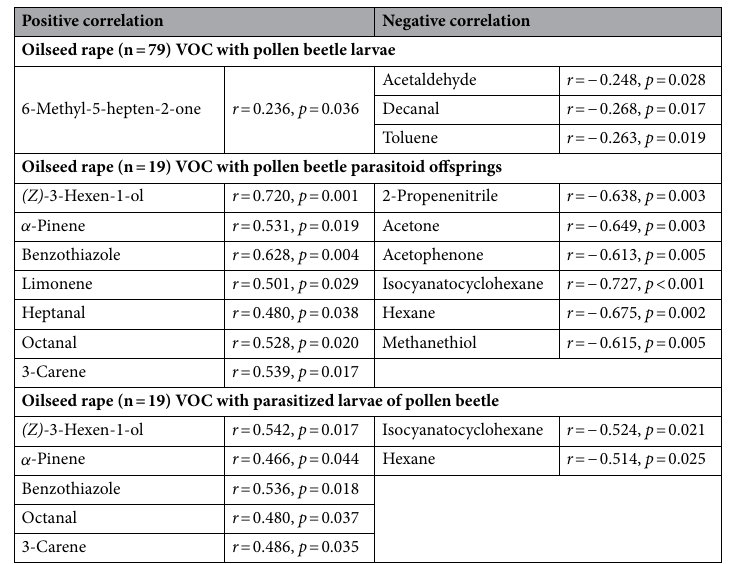
Table 3. Pearson correlation test results of VOC emission (LOG-transformed) of pollen beetle larvae, parasitoid offspring and parasitized larvae of pollen beetle (count of unique individuals despite of single- or multi-infestation). Untreated plants VOCs were used for the correlation test with pollen beetle larvae and infested plants VOCs for correlation test with beetle parasitoid offspring and parasitized larvae of pollen beetle.